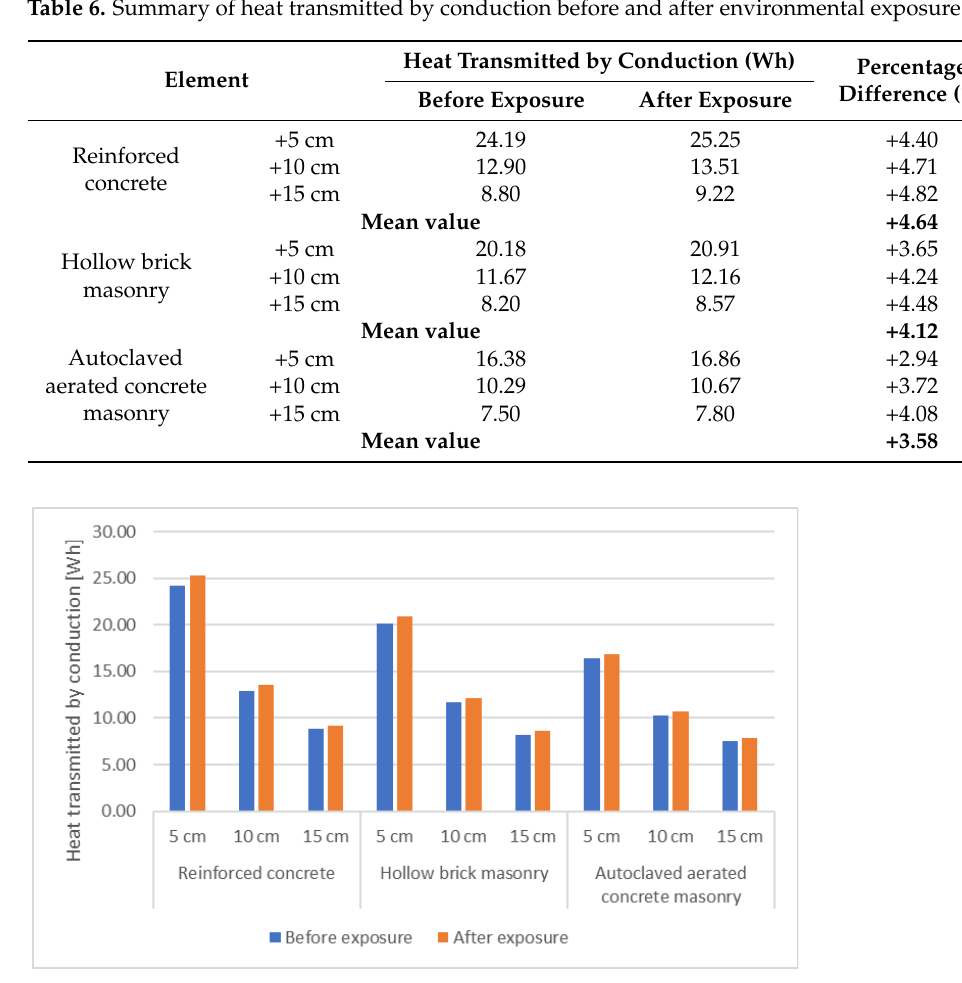
Figure 6. Graphic representation of the variation of the heat transmitted by conduction.